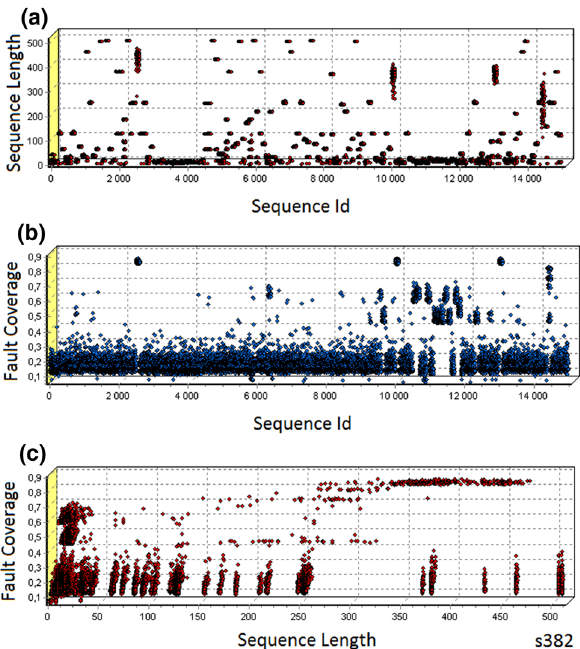
Fig. 12 Simulation graph for s382 a sequence length vs. sequence id, b FC vs. sequence id and c FC vs. sequence length. STP (Id 1–7500),